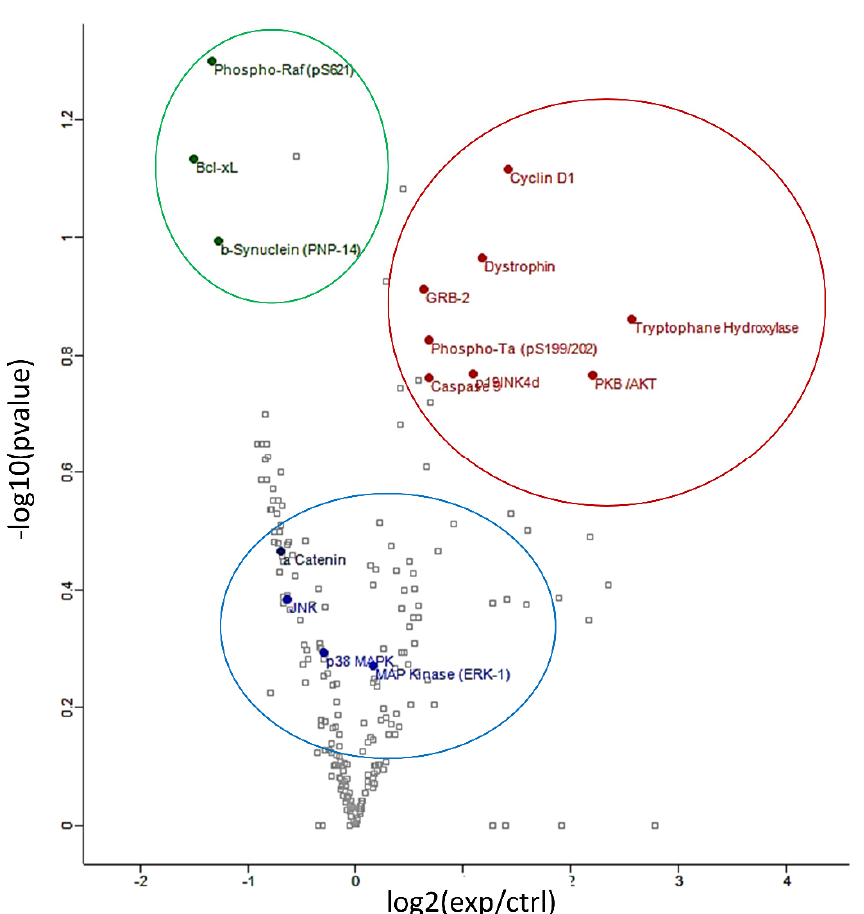
Figure 2. Volcano plot of differentially regulated proteins identified by protein array: under-ex- pressed proteins are shown in green, overexpressed proteins are shown in red and proteins verified by Western blot analyses are shown in